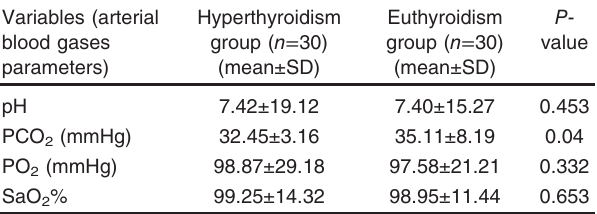
Table 8 Comparison of arterial blood gases parameters between hyperthyroid and euthyroid